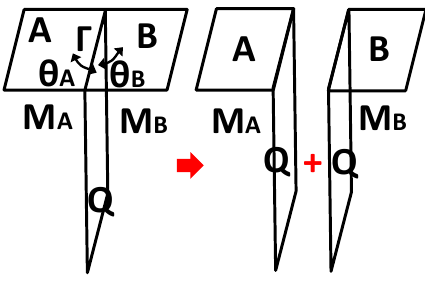
Figure 6 . Separating a Poincar(cid:19)e AdS into two parts M A and M B . The boundary of the Poincar(cid:19)e AdS is A [ B , which is a plane. The separation is done along the surface Q